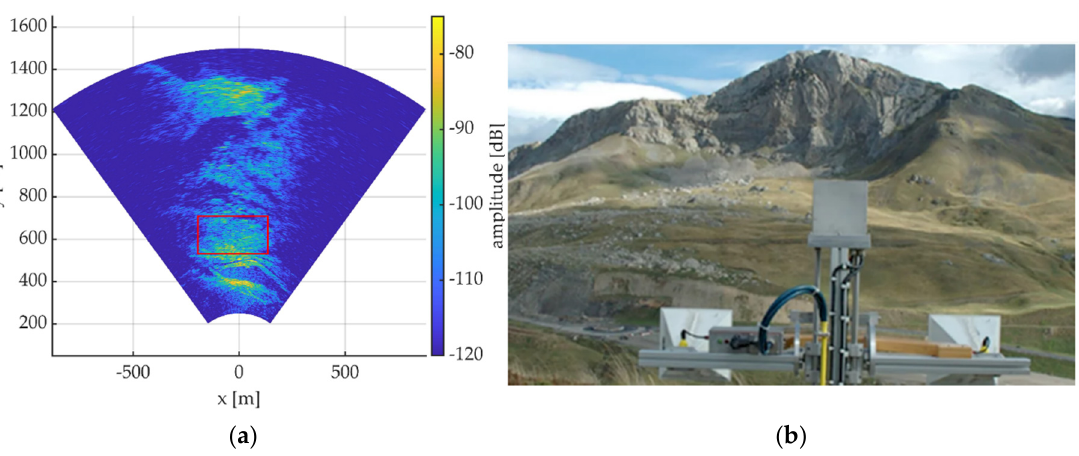
Figure 3. ( a ) Amplitude GBSAR image on the monitored slope, in Formigal, Spain; the red box highlights the area chosen for analysis. ( b ) Picture of the illuminated area.